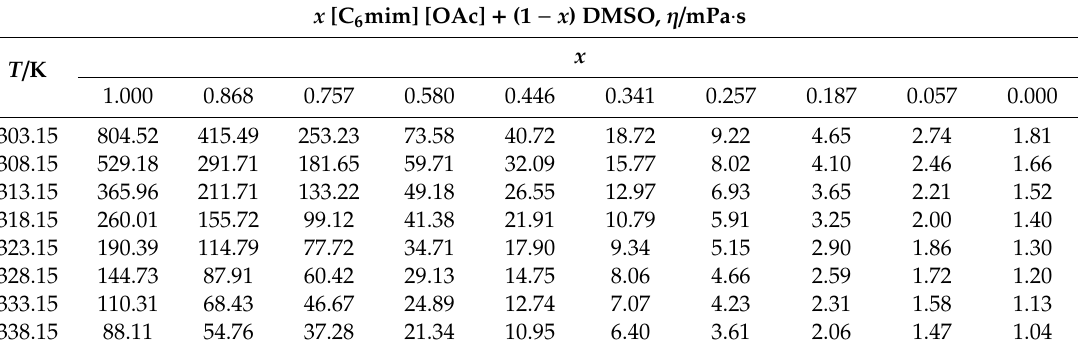
Table 12. Experimental viscosities of [C 6 mim] [OAc] with DMSO at (0.0967 ± 0.002) MPa from 303.15 to 338.15 K and x is IL mole